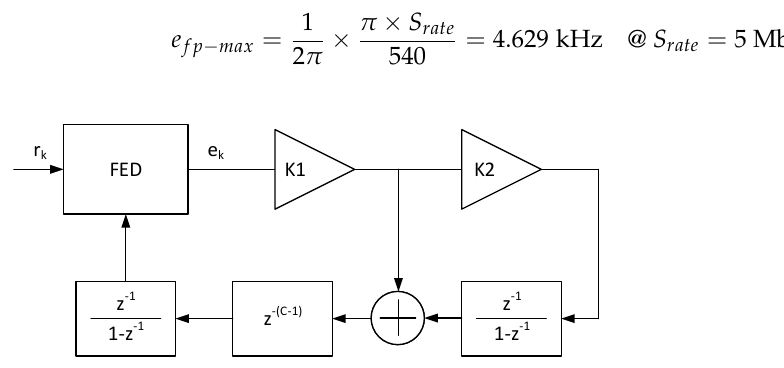
Figure 22. Frequency feedback loop logical